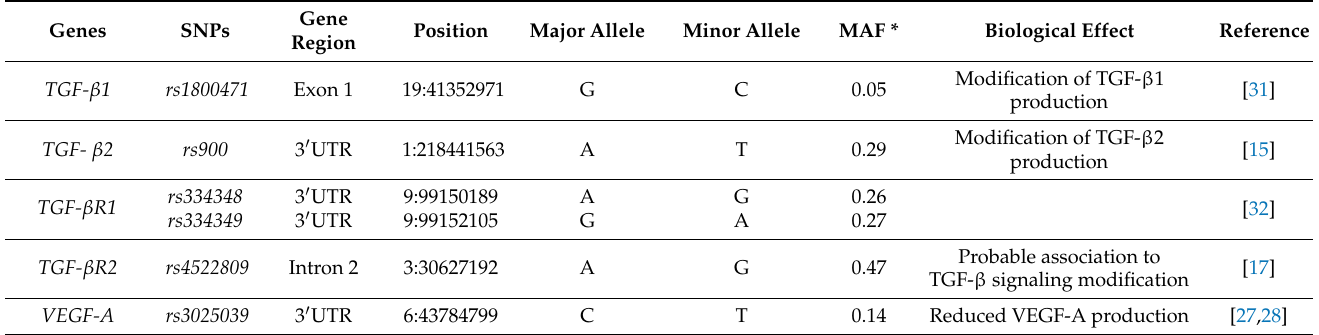
Table 2. Genes, reference number (rs), localization and position of SNPs investigated in the